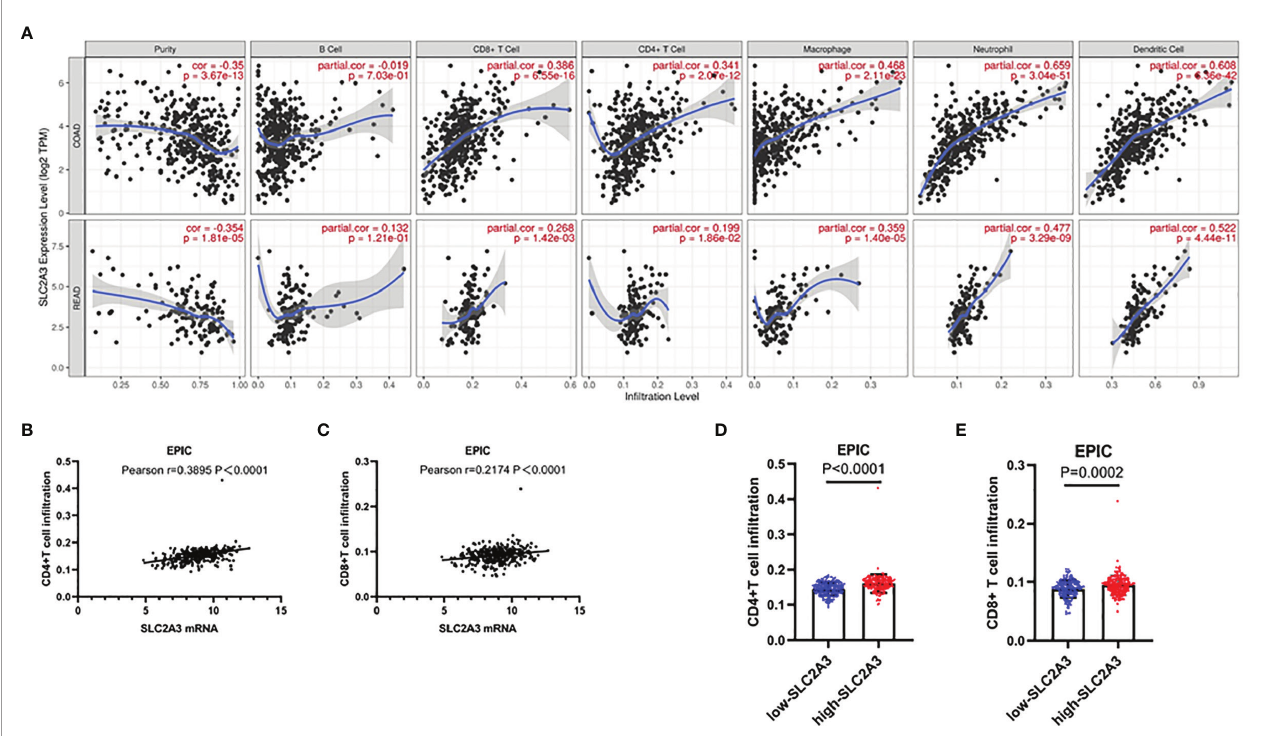
FIGURE 6 | SLC2A3 signi fi cantly correlated with T cell in fi ltration in CRC based on (A) TIMER and (B, C) EPIC algorithm; (D, E) SLC2A3 expression increased CD4+ and CD8+T cell in fi ltration in CRC based on EPIC